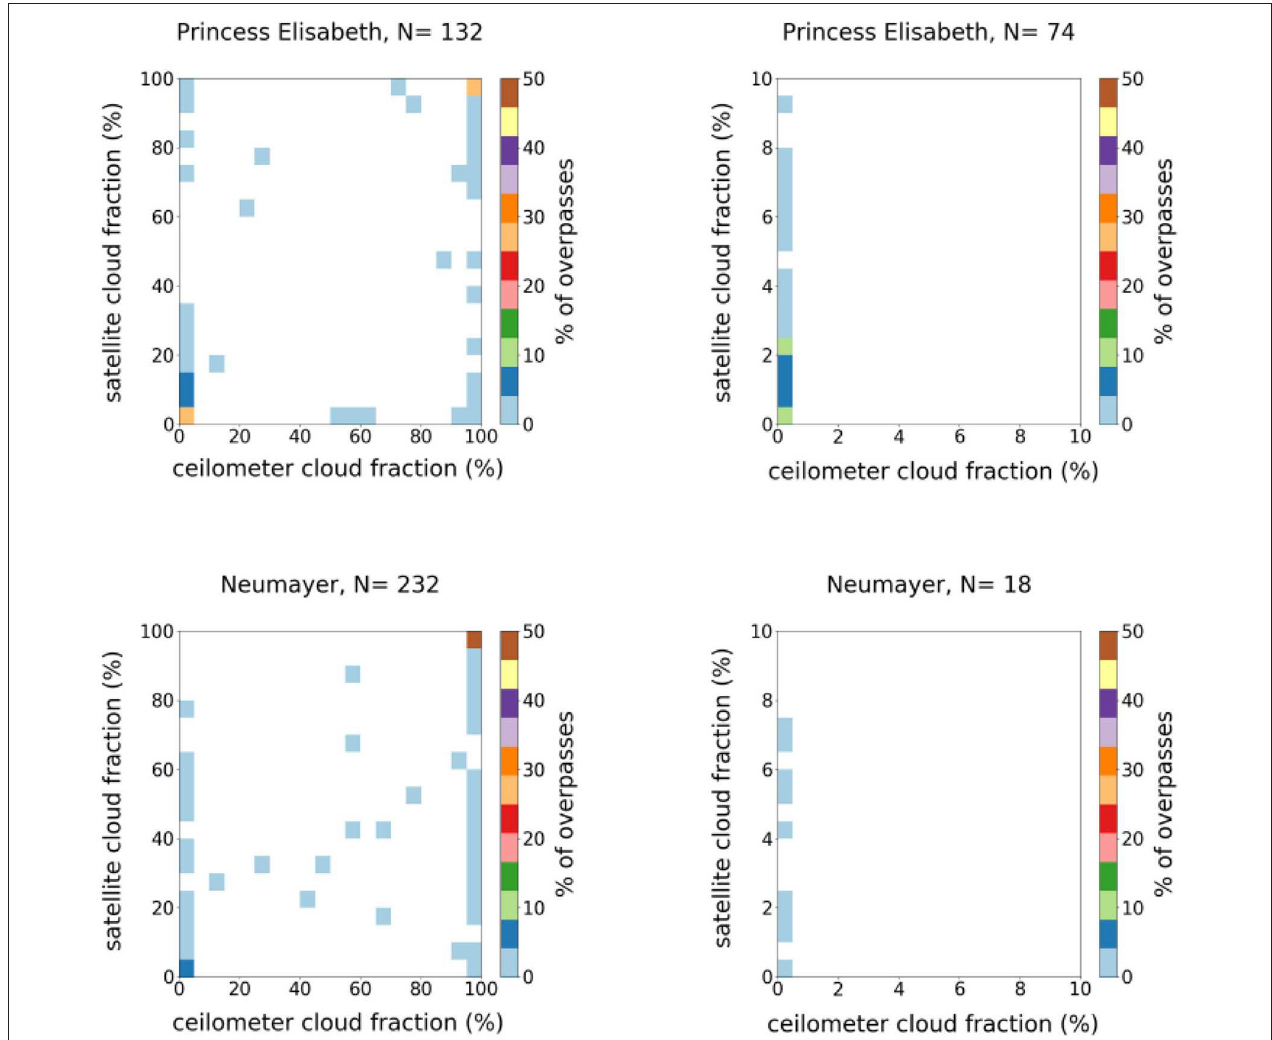
FIGURE 3 | Concurrent measurements of cloud fraction at top Princess Elisabeth and bottom Neumayer stations, as derived from the ceilometer signal (x-axis) and the satellite return (y-axis). The right graph is a zoom between 0 and 10 % for both detection methods.